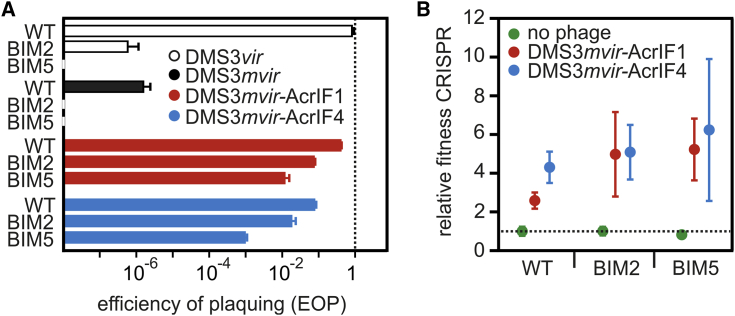
CRISPR-Cas Confers Partial Immunity to Acr-Phages(A) Efficiency of plaquing (EOP) of DMS3vir (white bars) on PA14 WT (completely sensitive to DMS3vir), BIM2 (one spacer targeting DMS3vir), and BIM5 (four spacers targeting DMS3vir); EOP of DMS3mvir (black bars), DMS3mvir-AcrIF1 (red bars), and DMS3mvir-AcrIF4 (blue bars) on PA14 WT (one spacer targeting DMS3mvir, DMS3mvir-AcrIF1, and DMS3mvir-AcrIF4), BIM2 (two spacers targeting DMS3mvir, DMS3mvir-AcrIF1, and DMS3mvir-AcrIF4), and BIM5 (five spacers targeting DMS3mvir, DMS3mvir-AcrIF1, and DMS3mvir-AcrIF4). Data correspond to the mean of six independent replicate experiments. Error bars represent 95% confidence intervals (CI).(B) Fitness of bacteria with CRISPR resistance (PA14 WT, BIM2, and BIM5) relative to a phage-sensitive CRISPR-KO strain in the absence of phage (green data points) or in the presence of phage DMS3mvir-AcrIF1 (red data points) or phage DMS3mvir-AcrIF4 (blue data points). Data correspond to the mean of six independent replicate experiments; error bars represent 95% CI.See also Figure S1.